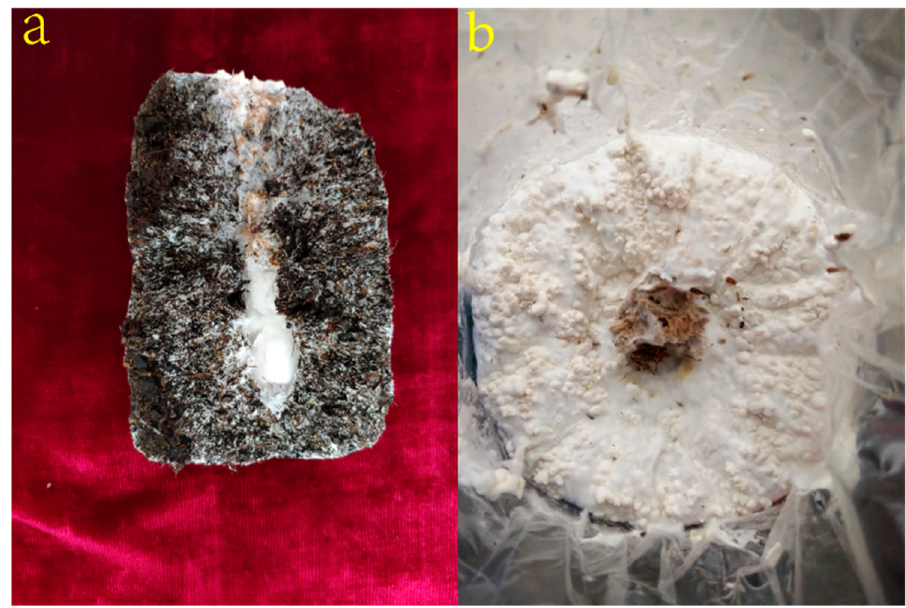
Figure 1. Morphological features of P. eryngii at mycelia ( a ) and primordium stages ( b ).